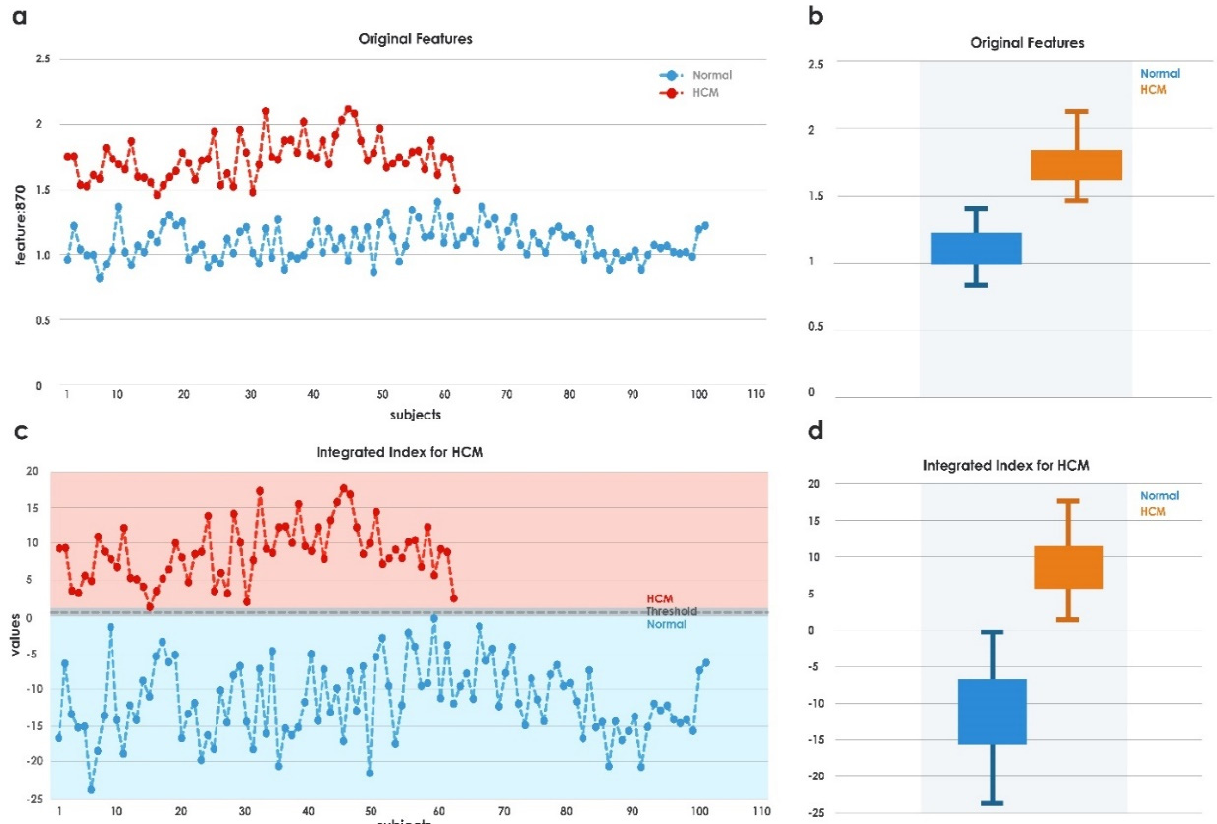
Figure 8. Feature distribution before and after indexing. Table 2. Architecture details of the various deep-learning methods used in this